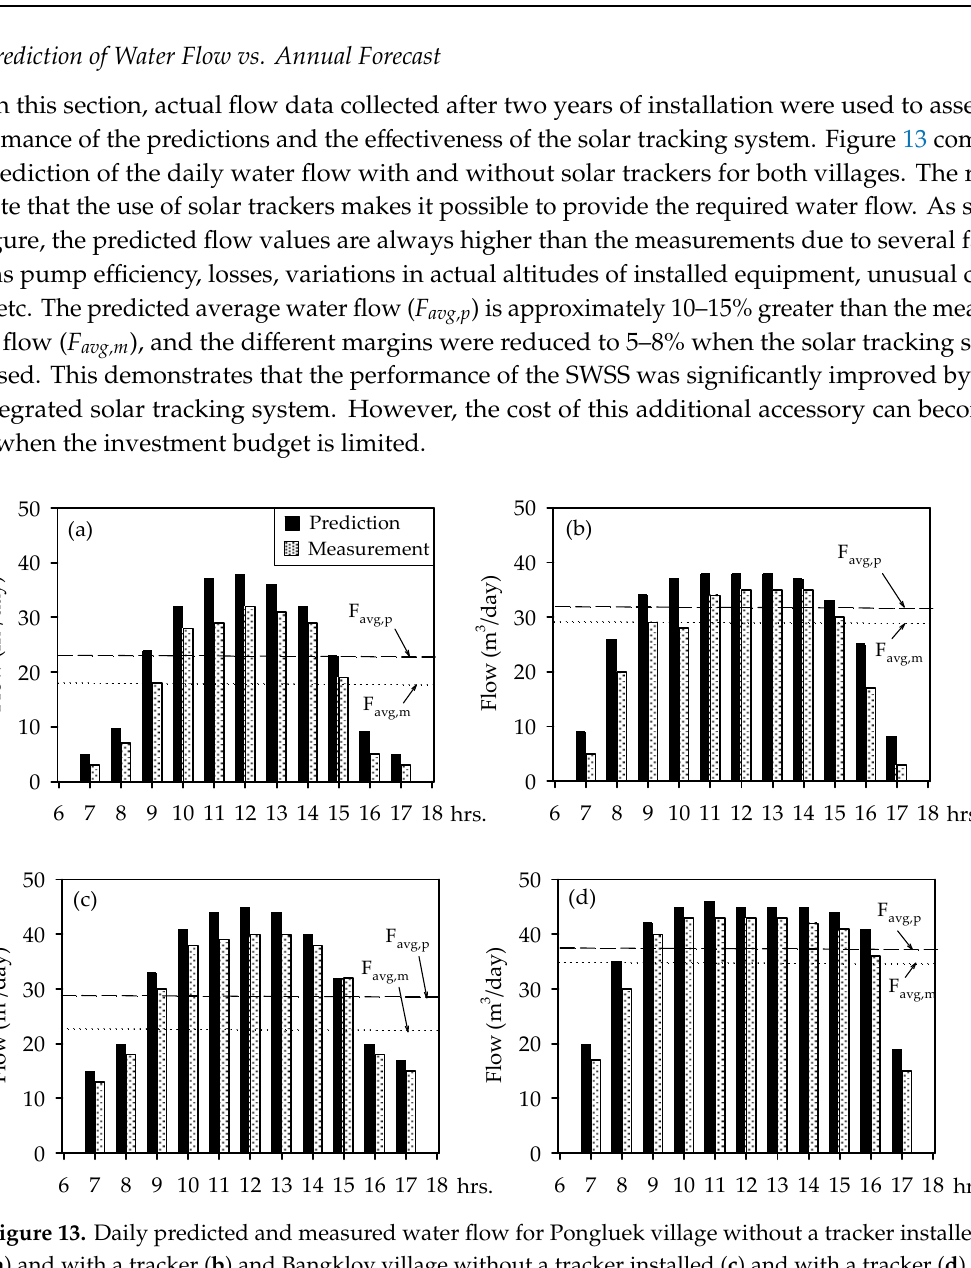
Figure 12. Global horizontal irradiance in different months of a year at case-study villages ( a ) on sunny days; ( b ) on cloudy days. Note that both locations (Bangkloy and Pongluek) are close to each other.